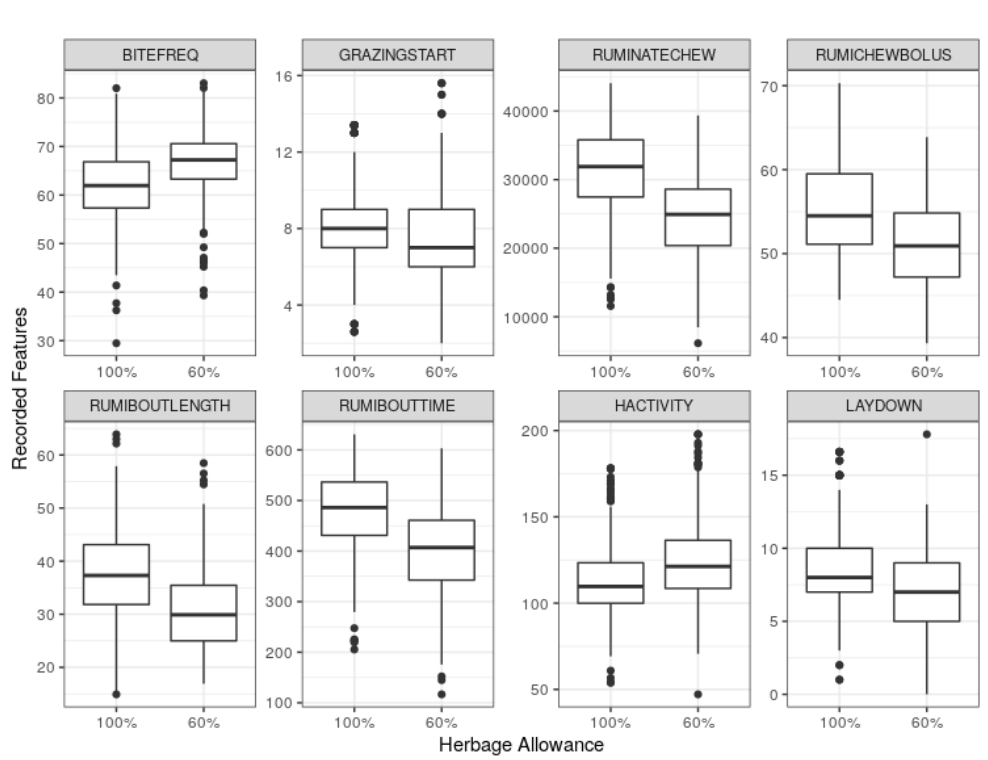
Figure 1. Side-by-side box plots of selected variables using the combined data for sufficient (100%) and insufficient (60%) herbage allowance